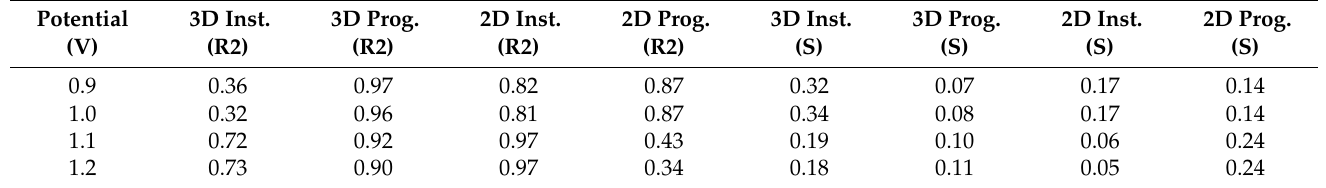
Table 2. Coefficients of determination (R 2 ) and standard errors (S) calculated by fitting the experimental data with the theoretical models (Equations (1)–(4)).